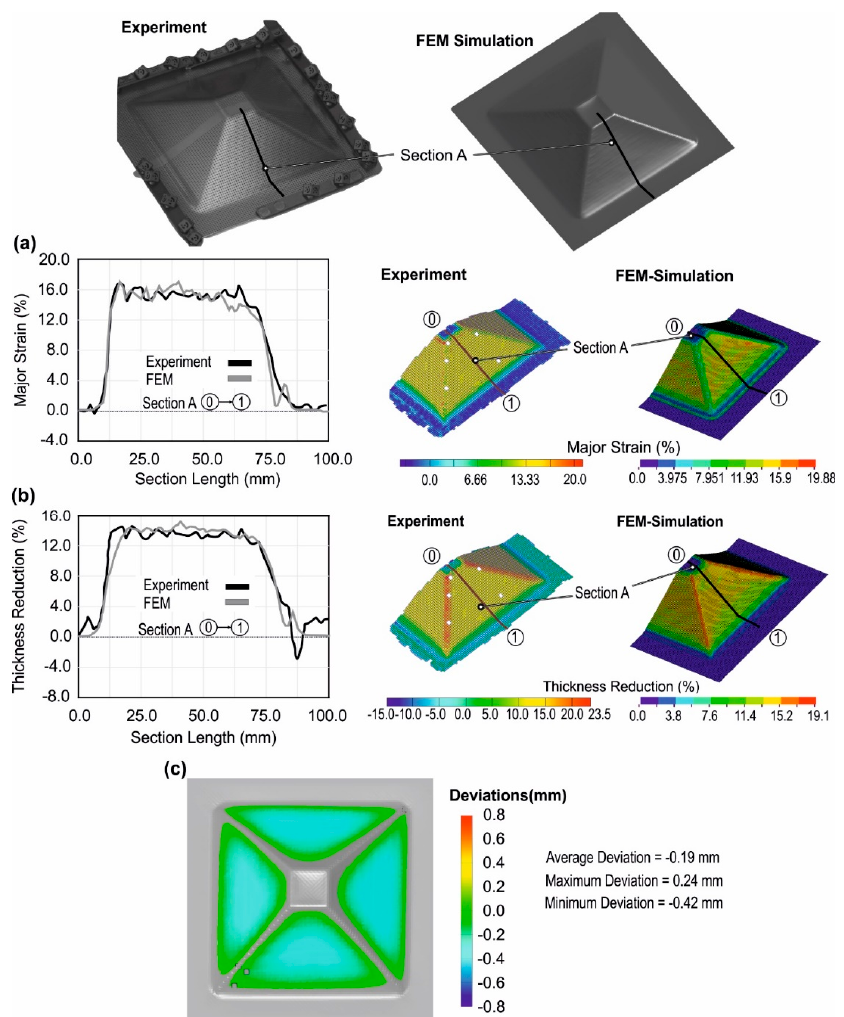
Figure 7. Comparison of the ( a ) major principle strains, ( b ) thickness reduction, and ( c ) formed geometries from the experiment and simulation for Experiment 1.